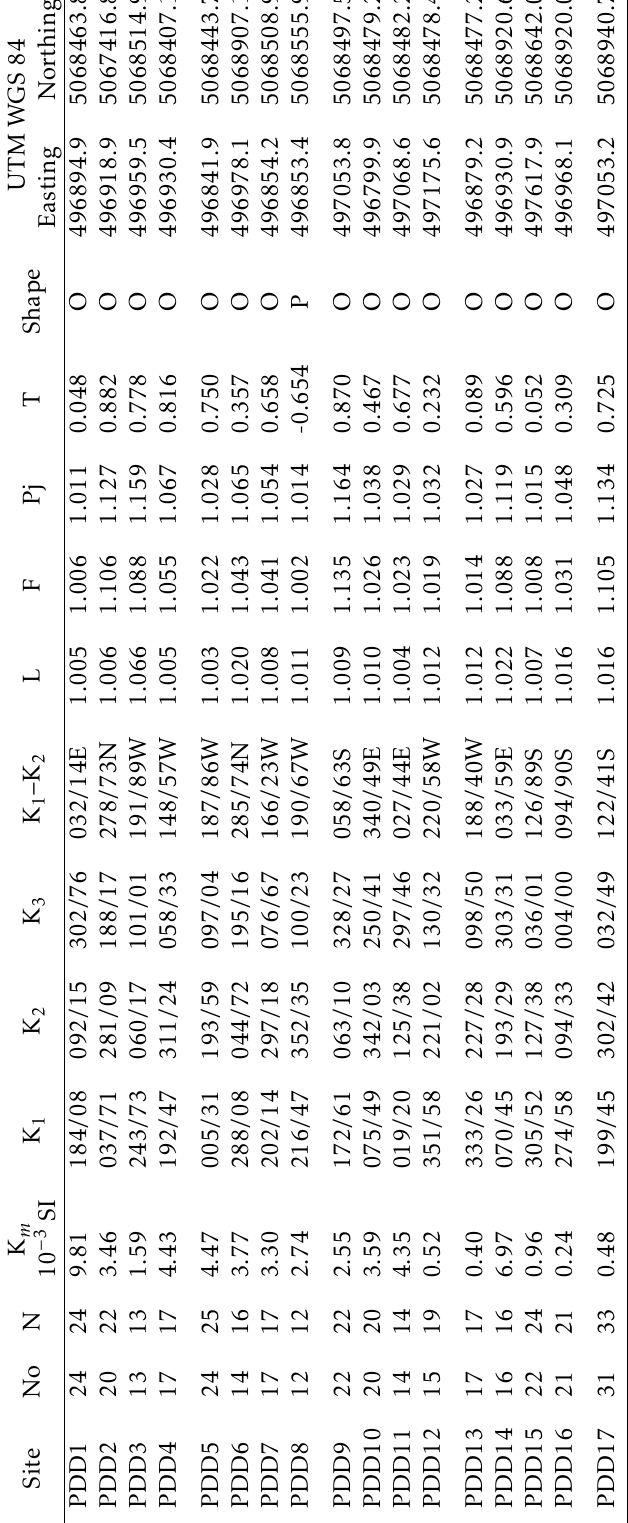
Table A1 – Anisotropy of Magnetic Susceptibility Data from the Puy de